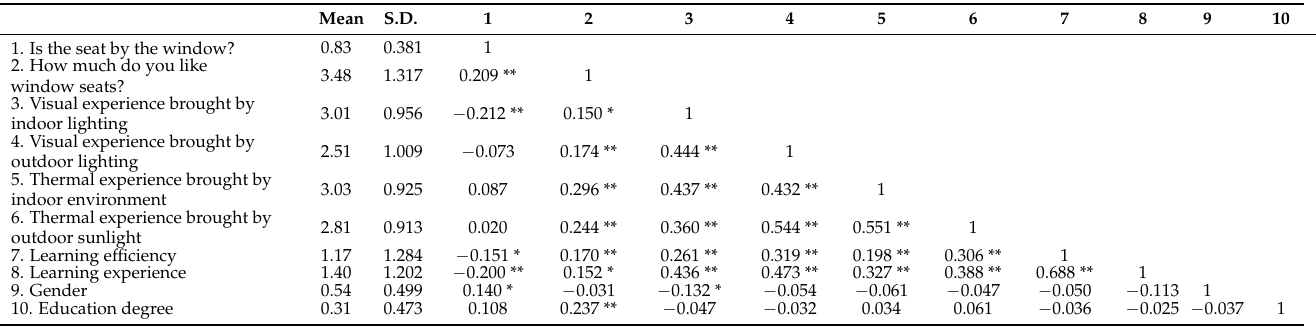
Table 1. Descriptive statistics and Pearson correlation matrix (N = 280).